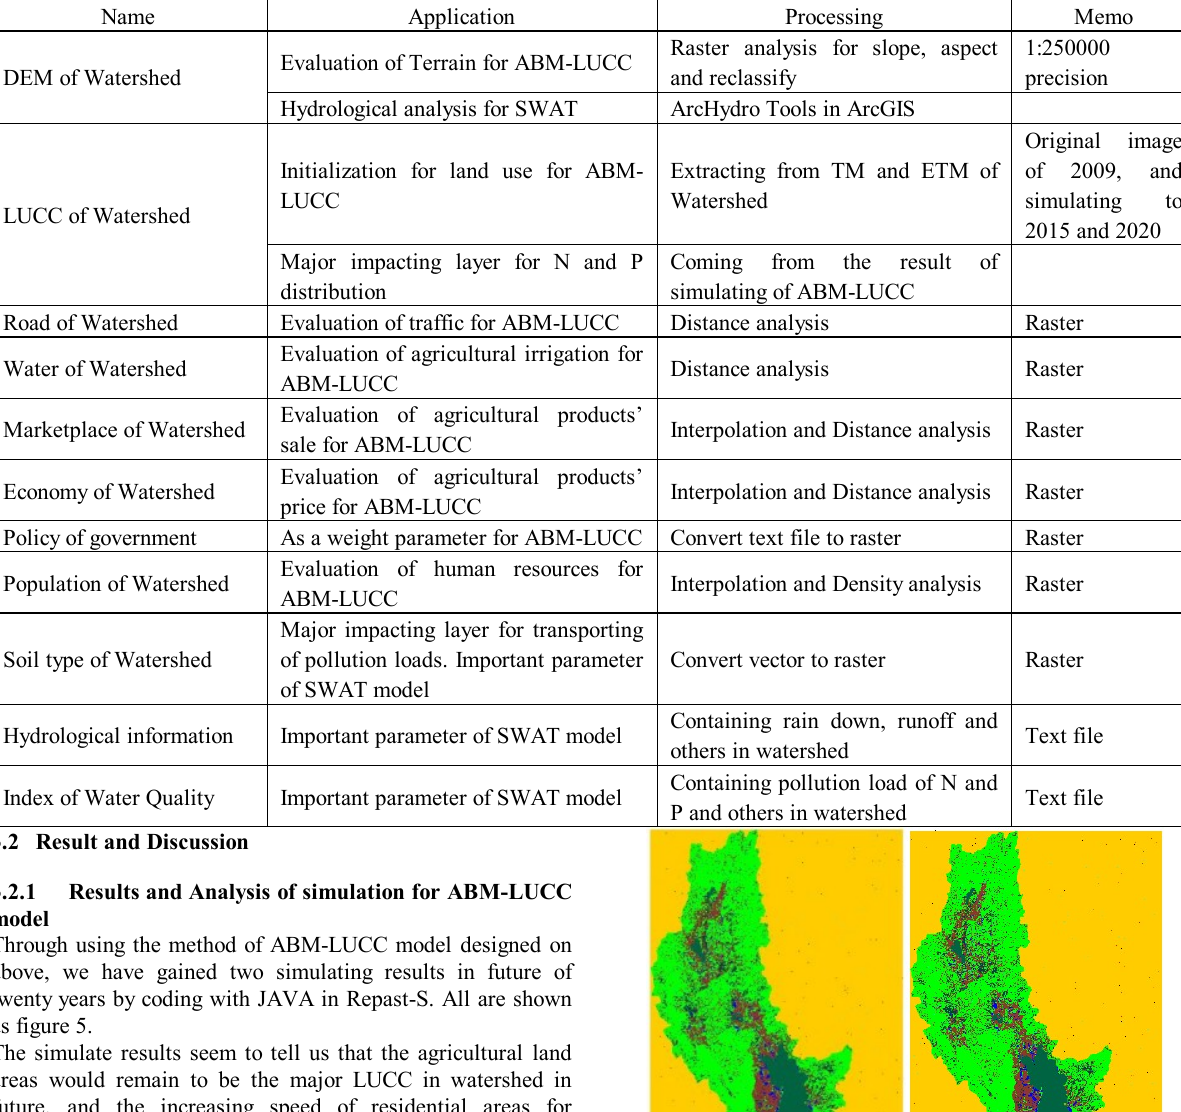
Table 1. Data Requirements and Handling for ABM-LUCC and SWAT model by Integrating ArcGIS